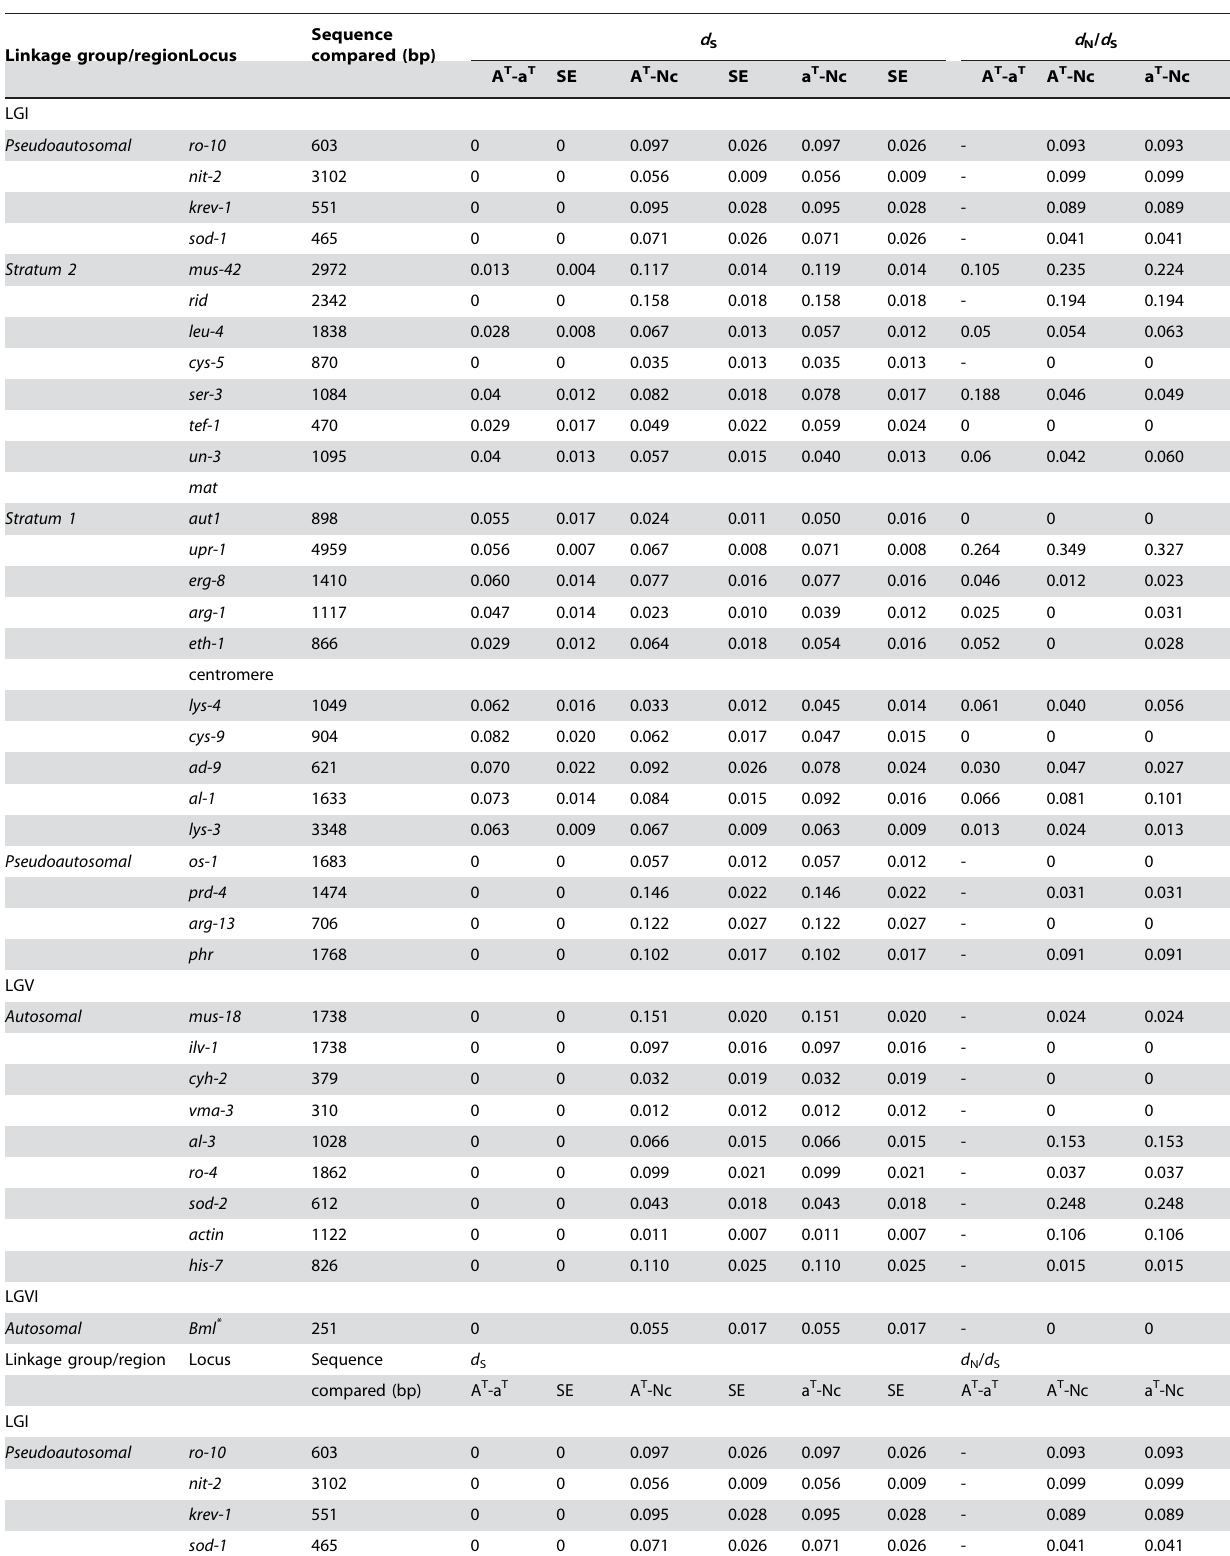
Table 2. Sequence Divergence between Alleles of Single Mating-Type Component Strains of the Heterokaryotic N. tetrasperma Strain P581 (A T -a T ) and between each of the Mating-Type Strains and the N. crassa Genome Sequence (A T -Nc; a T -Nc).